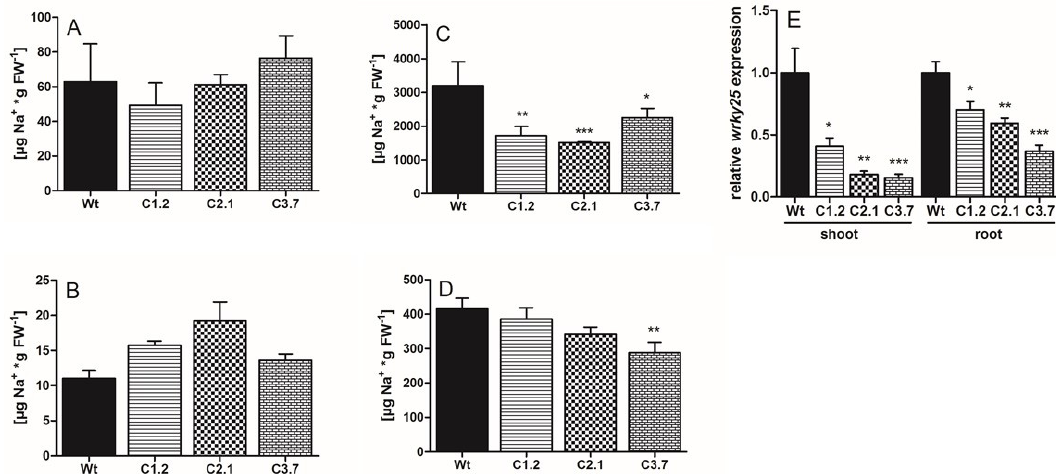
Figure 7. Sodium content and relative expression levels of the salt-stress indicator gene wrky25 in Wt and p35s::SOS1 c-term StrepII plants. Wt and p35s::SOS1 c-term StrepII plants were grown in hydroponic culture for five weeks and watered with ± 100 mM NaCl 72 h prior to measurement. Na + concentrations in leaves ( A ) and roots ( B ) under control and under salt stress conditions (leaves C , roots D ), quantified by IC. Relative transcript levels of wrky25 in Arabidopsis shoot and root tissues under salt stress conditions ( E ). Data are normalized to the housekeeping gene pp2a ( At1g13320 ). Values represent the mean of 3 biological replicates, each with 2 technical replicates. Error bars are ± SE. Data with *, **, *** are significant from Wt at p < 0.05, p < 0.01 or p < 0.001 (two-way ANOVA).